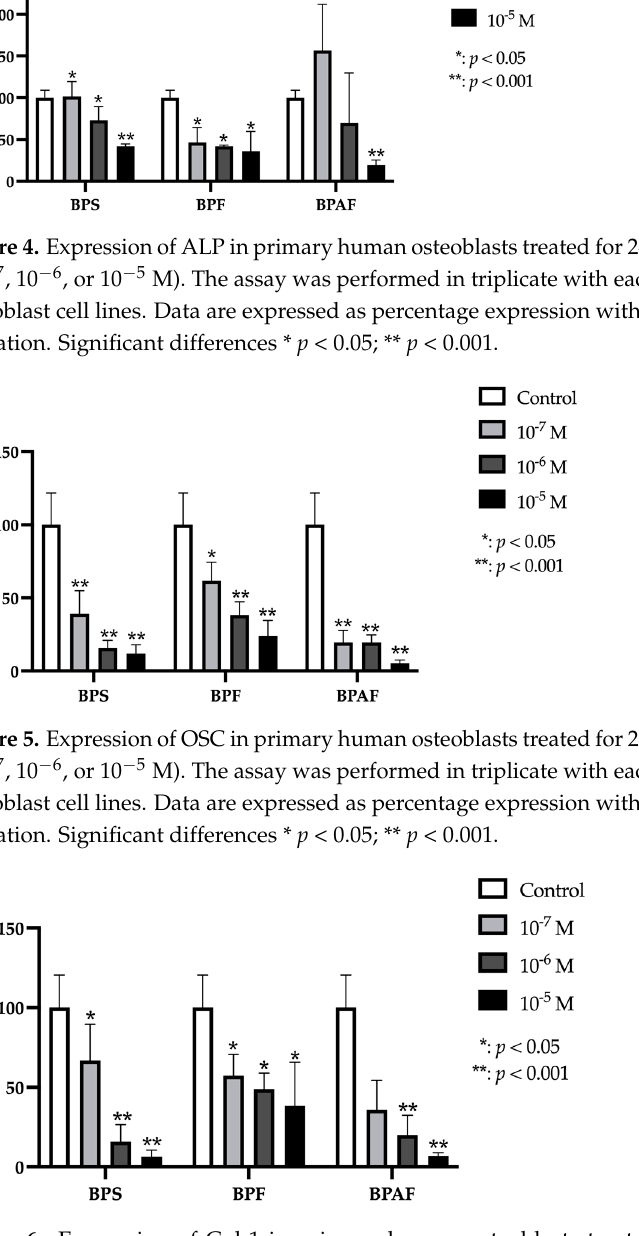
Figure 4. Expression of ALP in primary human osteoblasts treated for 24 h with bisphenol S, F, and AF (10 − 7 , 10 − 6 , or 10 − 5 M). The assay was performed in triplicate with each of the three primary human osteoblast cell lines. Data are expressed as percentage expression with respect to control ± standard deviation. Significant differences * p < 0.05; ** p < 0.001.